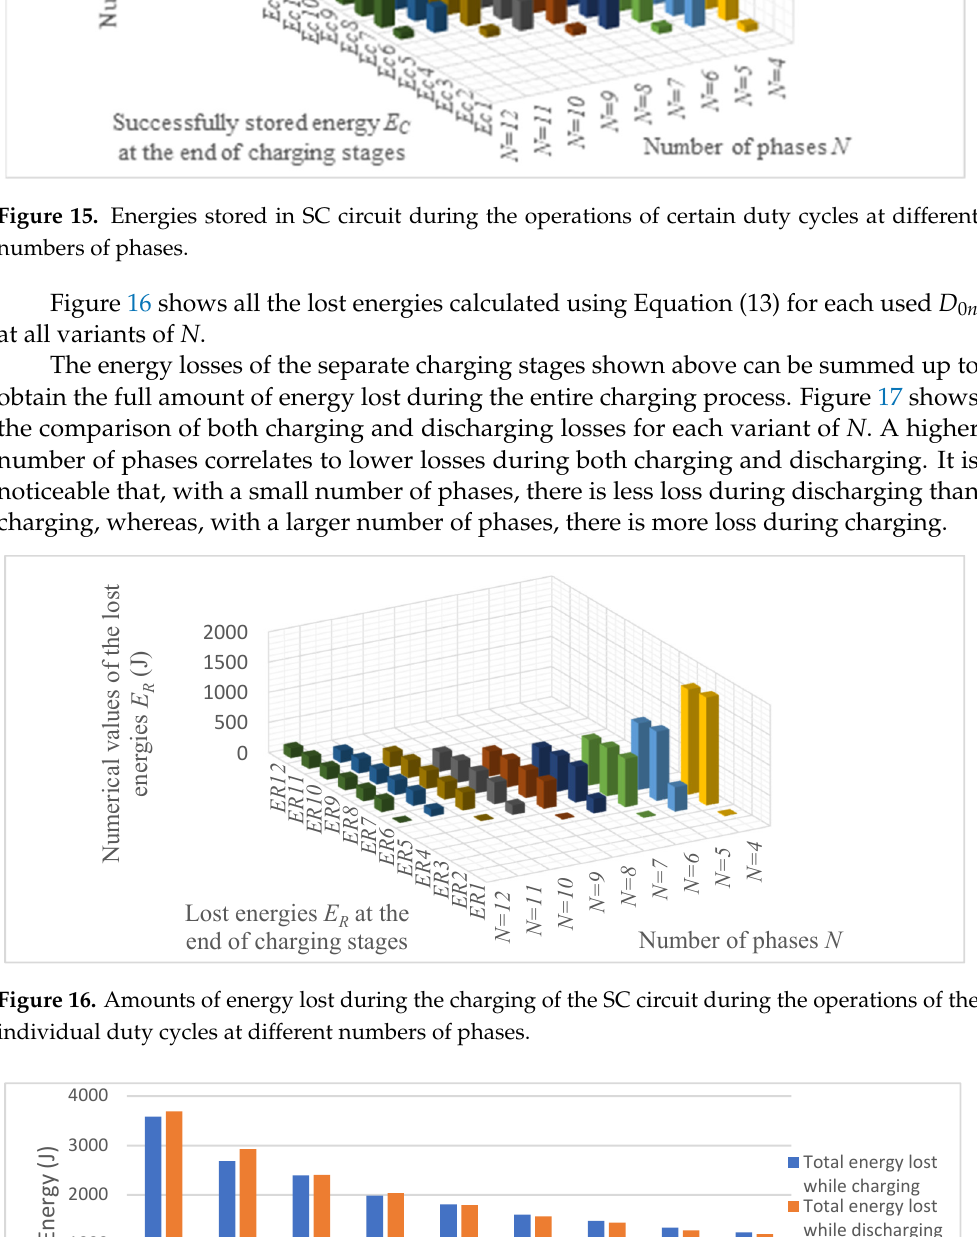
Figure 17. Comparative diagrams of total energies lost during charging and discharging of the SC circuit at different numbers of phases.